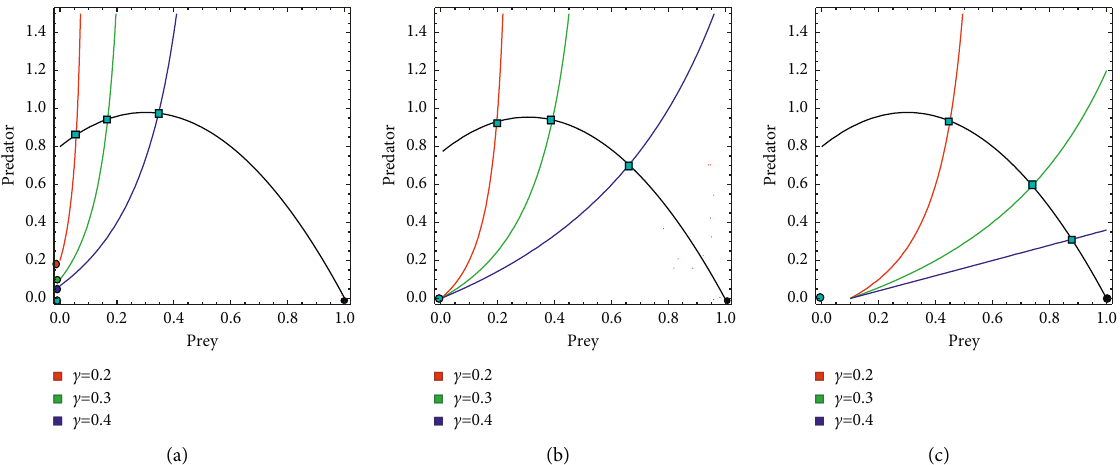
Figure 1: Nullcline plots for different values of m predator nullclines. Also, cyan dot implies E values are chosen as a